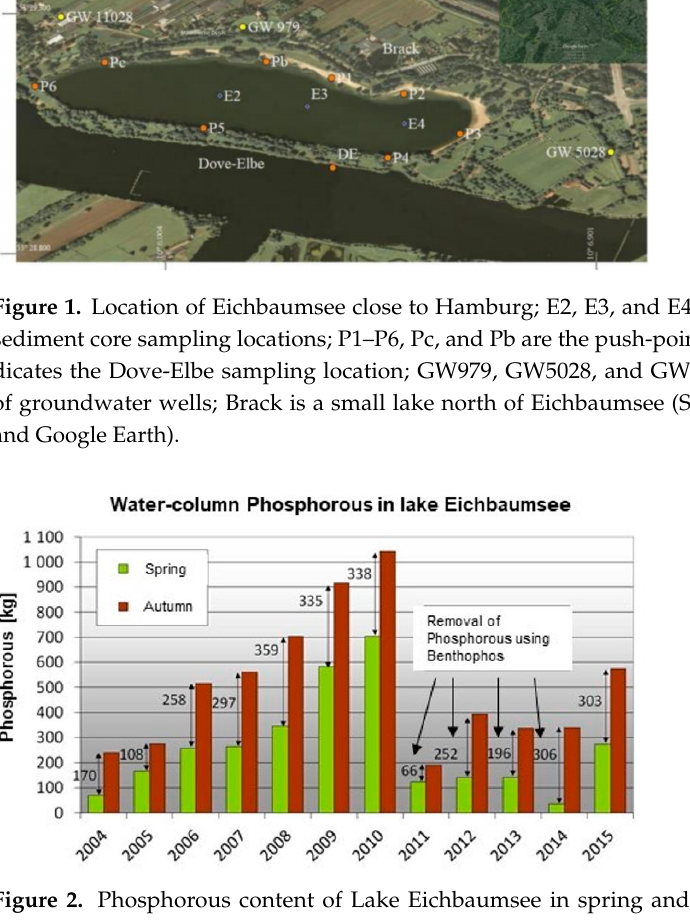
Figure 2. Phosphorous content of Lake Eichbaumsee in spring and autumn between 2004 and 2015. Numbers with arrows indicate the phosphorous increase (kg) between spring and autumn. The application of Bentophos ® in the winters 2011 through 2013 did not lead to a long-term reduction of the lake phosphorous content (modified from [28]).